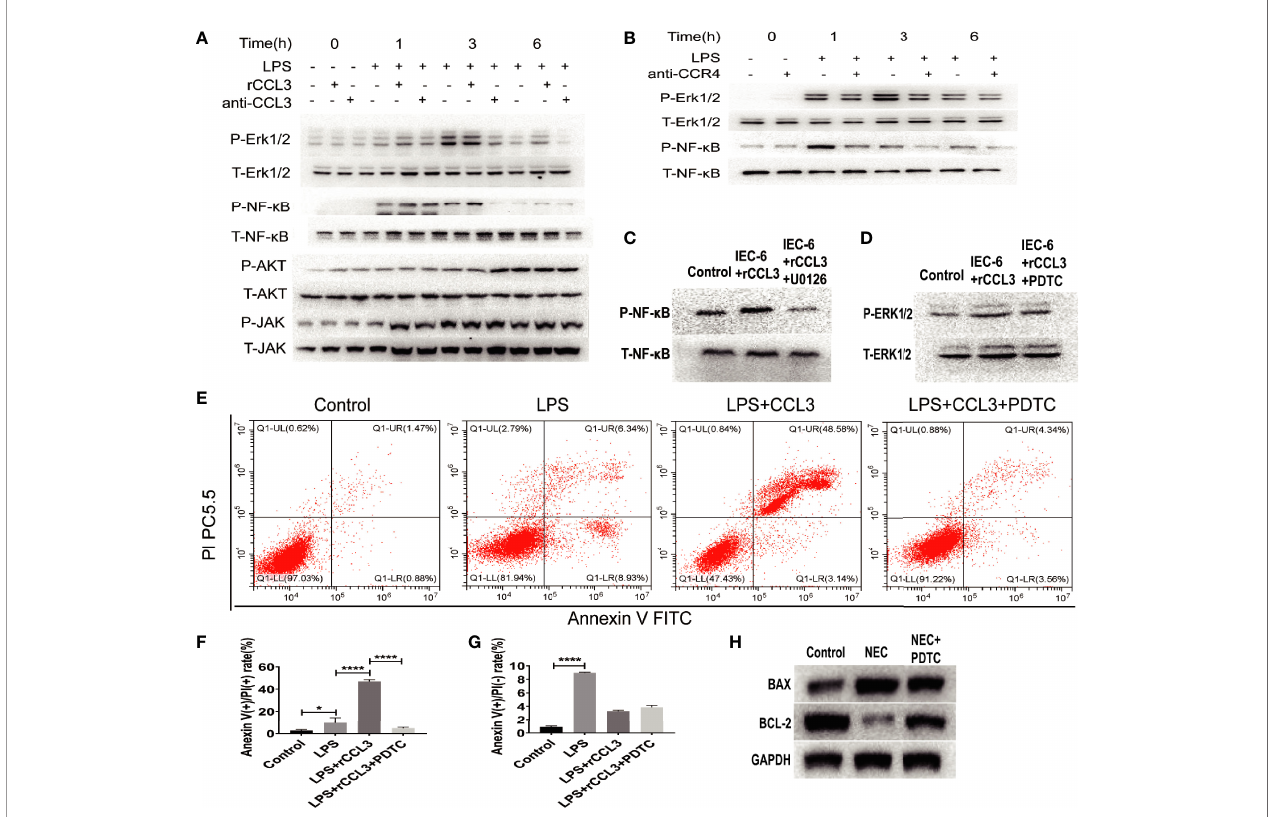
FIGURE 6 | CCL3 activates apoptosis-related signaling pathways through the CCL3-CCR4-ERK1/2-NK- k B signal axis. (A) IEC-6 cells were treatment with LPS, LPS+rCCL3 or LPS+anti-CCL3, then the cells were harvest at different time (0,1,3,6h) for signal molecule phosphorylation detection by WB. (B) IEC-6 cells were treatment with LPS or LPS+anti-CCR4, then the cells were harvest at different time (0,1,3,6h) for signal molecule phosphorylation detection by WB. (C) IEC-6 cells were treated with PBS control, rCCL3, or rCCL3+U0126 (an inhibitor of ERK1/2), and the phosphorylation of NF- k B was detected by western blotting. (D) IEC-6 cells were treated with PBS control, rCCL3, or rCCL3+PDTC, and the phosphorylation of ERK1/2 was detected by western blotting. (E-G) FCM was performed to evaluate the effects of PDTC on the apoptosis of the LPS-induced IEC-6 cells. Anexin (+) PI (-) represents early apoptosis and Anexin (+) PI (+) represents late apoptosis. *p < 0.05, ****p < 0.0001 when compared between groups. (Mann-Whitney U test) (H) NEC modeling mice were treated with PBS control or PDTC, then BAX and BCL2 expression in intestinal tissue were detected by western